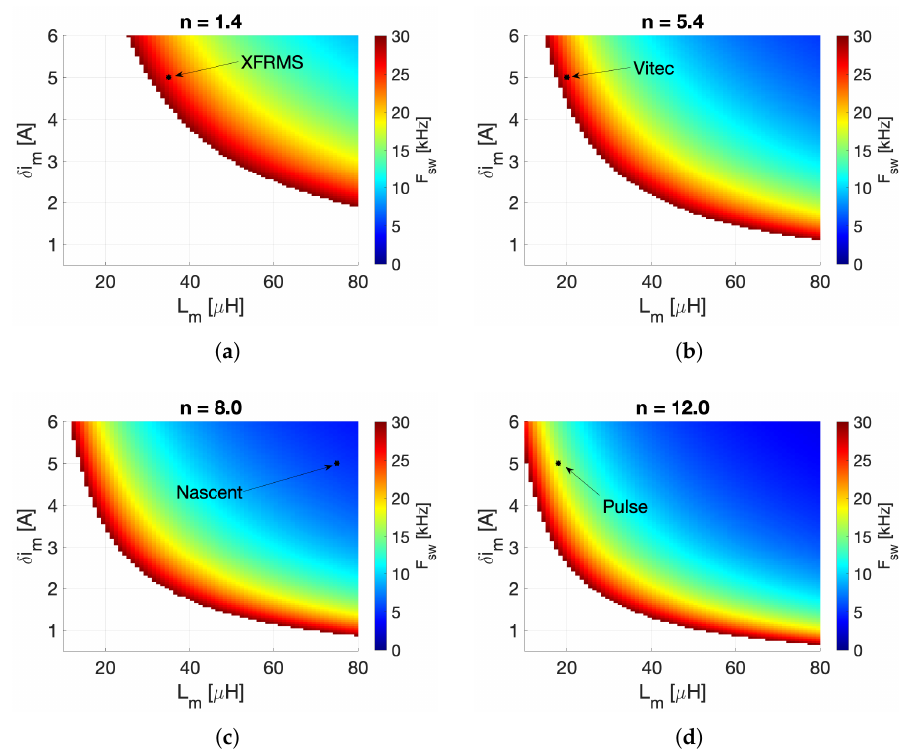
Figure 6. Effect of L m on both δ i m and F sw for turn-ratio values of some commercial HFT. ( a ) n = 1.4 and XFRMS HFT; ( b ) n = 5.4 and Vitec HFT; ( c ) n = 8.0 and Nascent HFT; ( d ) n = 12.0 and Pulse HFT.